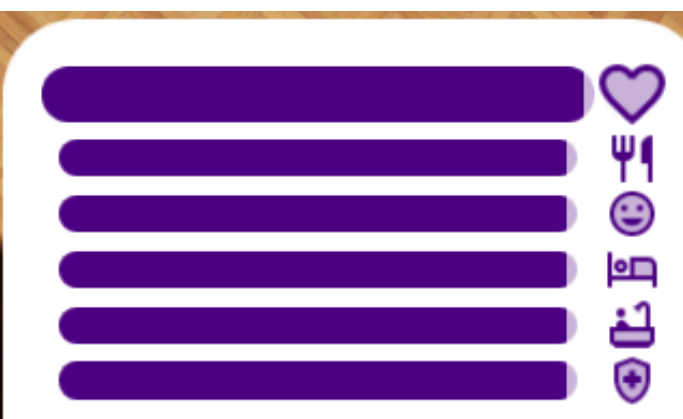
Figure 2. Quality of life and basic need indicators on the main user